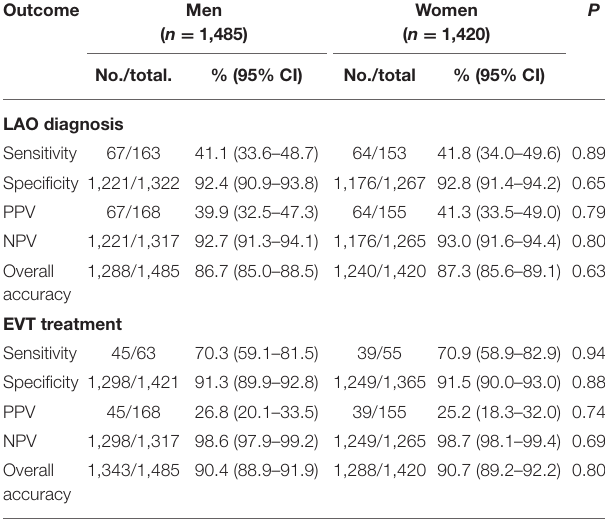
TABLE 3 | Triage accuracy for prediction of LAO and